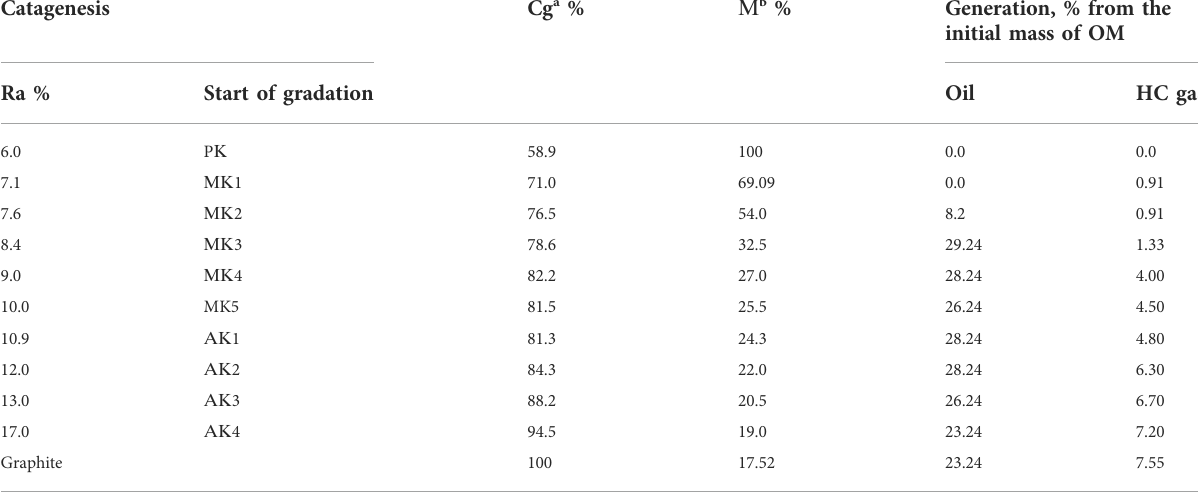
TABLE 3 Generation of oil, hydrocarbon gas and other volatile products of sapropel OM for recalculating at the beginning of catagenesis (Kontorovich et al., 2018).